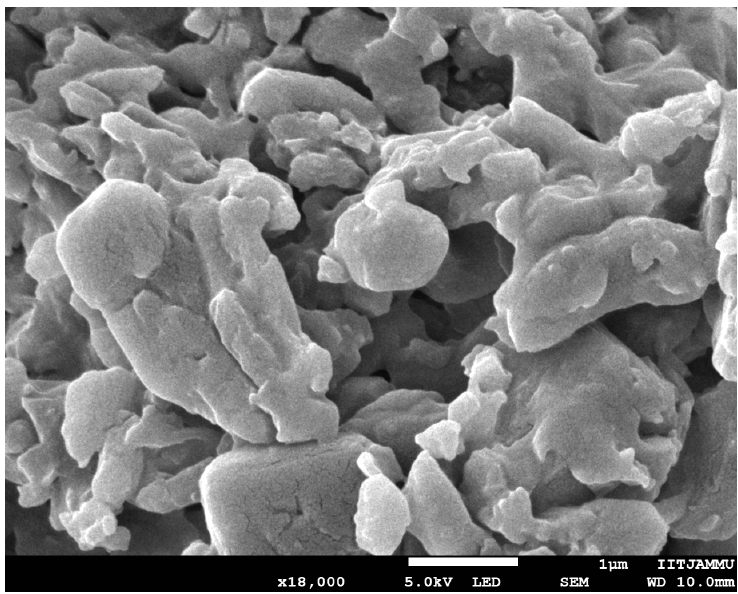
Figure 2. S EM image of coumarin-loaded SLN dispersions.